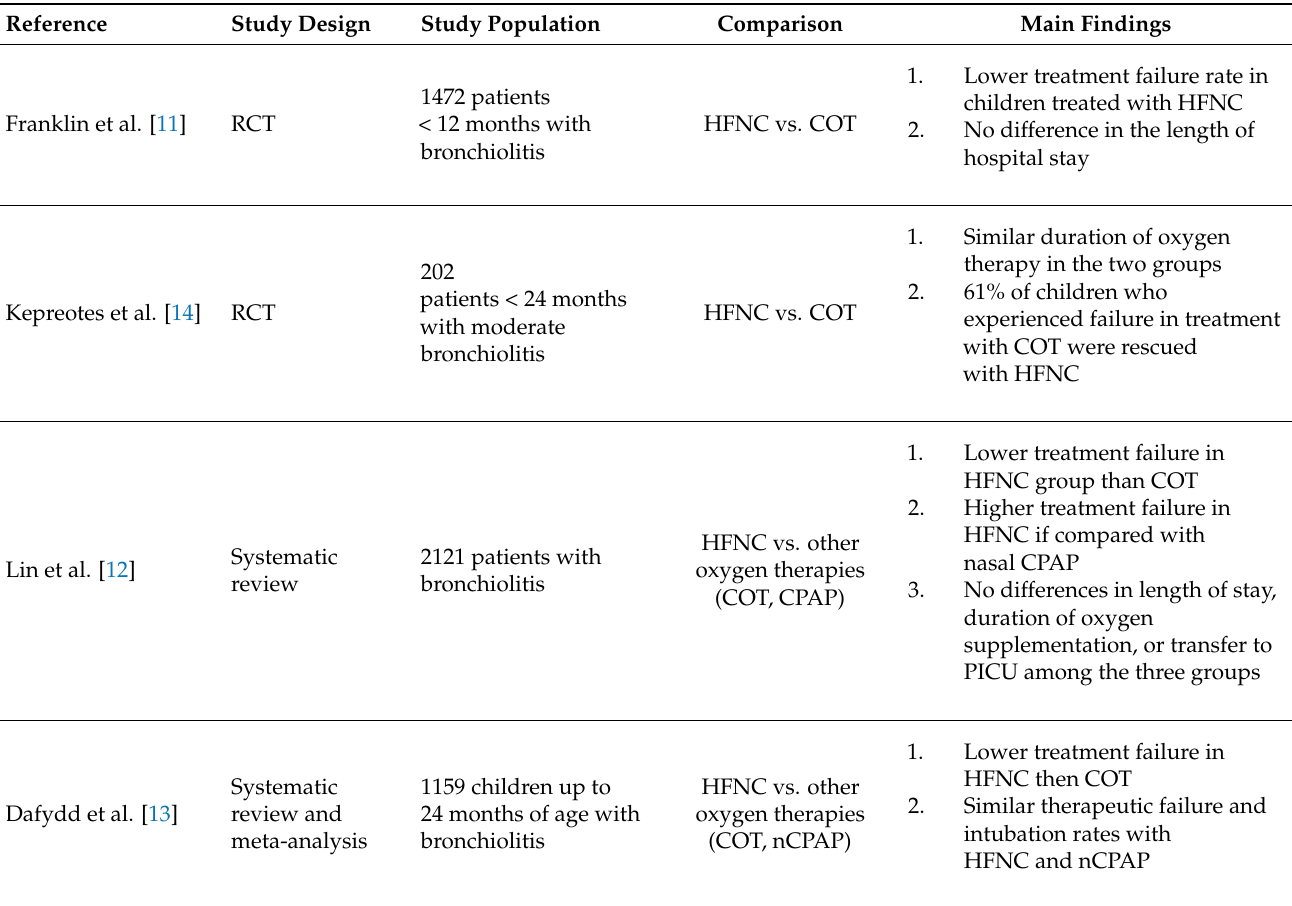
Table 1. Use of HFNC in children with